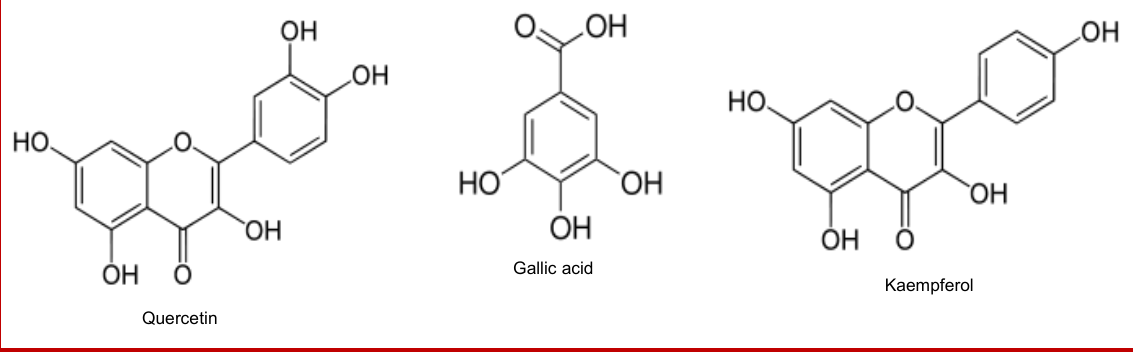
Figure 3 : Hepatoprotective constituents of C.